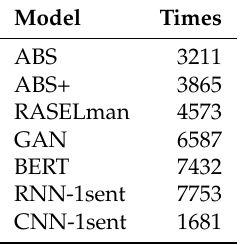
Table 4. The Computation